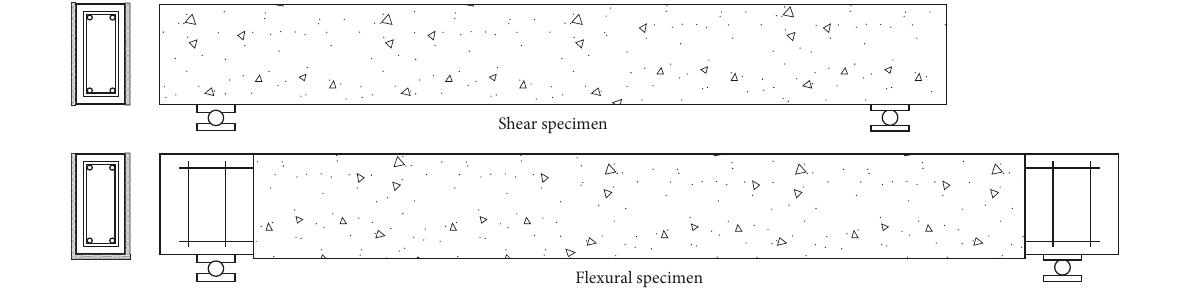
Figure 7: Side elevation of NSC beams jacketed with UHPC.